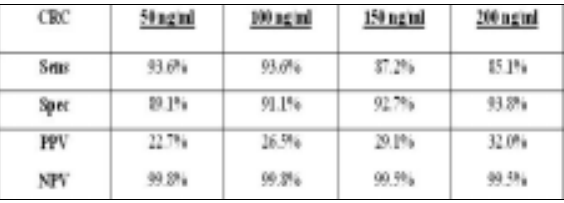
Conclusions: A higher cut off for i-FOBT can reduce strain on colonoscopy capacity in the start up phase